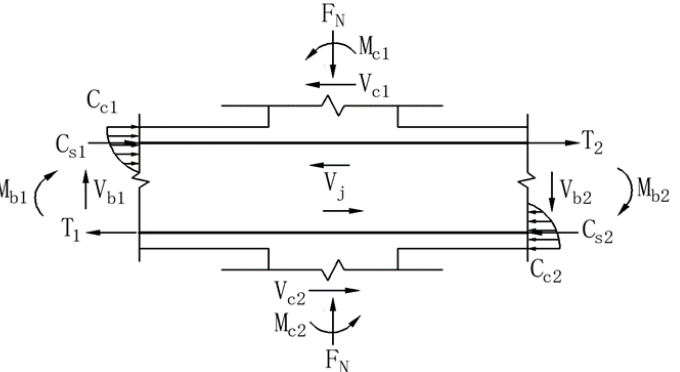
Figure 26. Sketch of forces in joint core.